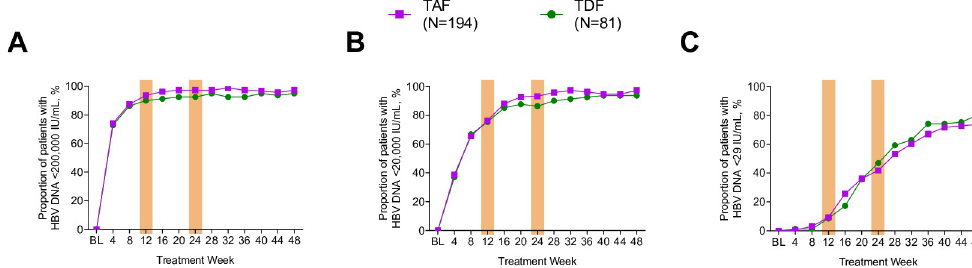
Fig 1. Rates of viral decline to < 200,000 IU/mL, < 20,000 IU/mL, and < 29 IU/mL. TAF, tenofovir alafenamide; TDF, tenofovir disoproxil fumarate.